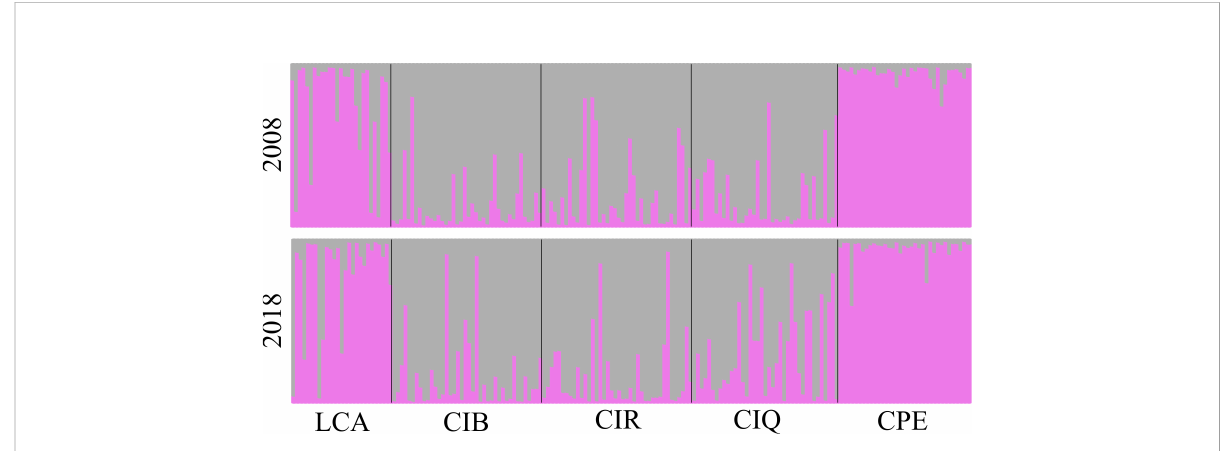
FIGURE 6 Structure analysis (STRUCTURE v. 2.3.4) of Macrocystis pyrifera individual assignments to two genetic co-ancestry groups. Upper pannel 2008 samples and lower pannel 2018/19 samples. Bars represent proportions of individual genetic assignment. Individual genetic assignments for all sites did not change temporally during the period studied.